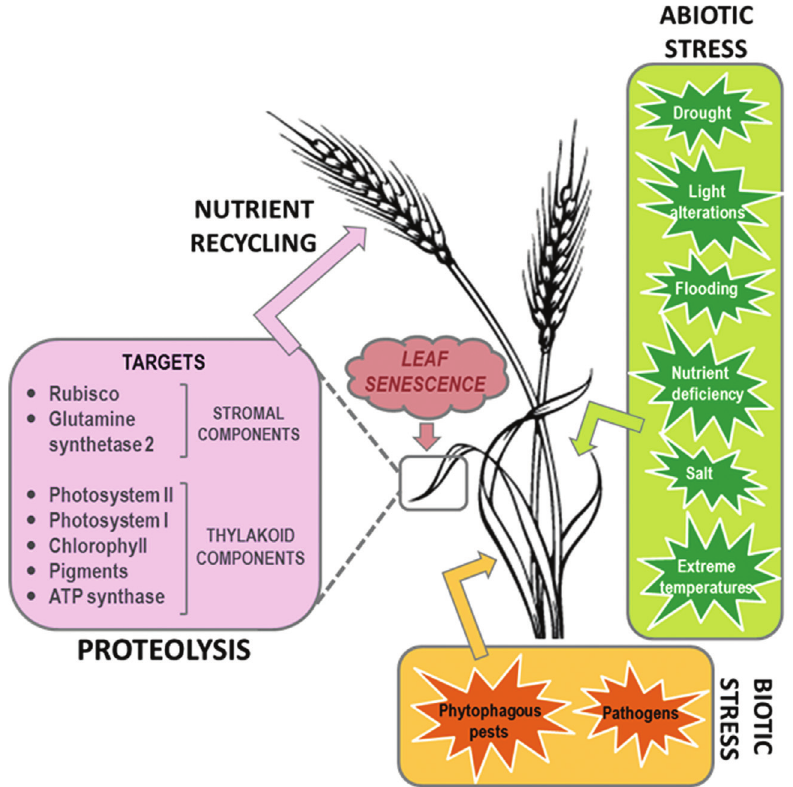
Figure1 -Physiologicaleventsinvolvedininduced-senescencemediatedbybiotic/abioticstresses.Multiplebioticandabioticstressesinduceleafsenes- cencecharacterizedbyadismantlingoforganellesandproteolysis,mainlyfromchloroplasticproteins.Inconsequence,proteinbreakdownandmobiliza- tion from stressed tissues to growing and sink organs are the major metabolic features essential for nutrient